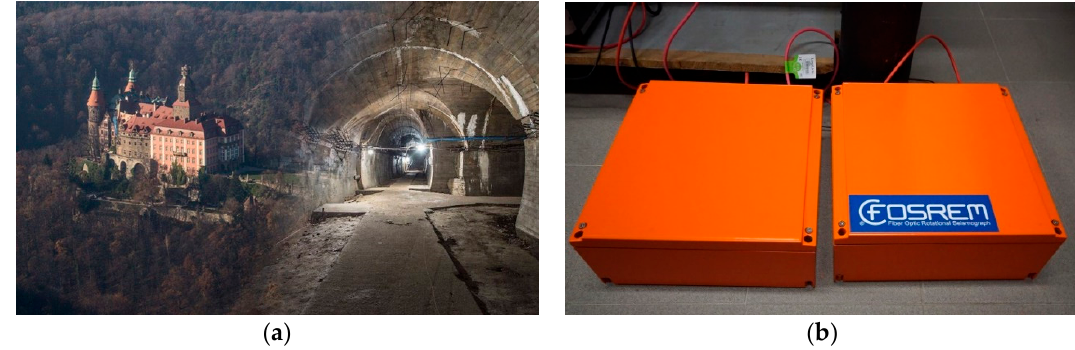
Figure 7. FOSREMs’ field application: ( a ) Ksi ąż castle with view of the underground tunnel located below the surface of the castle, ( b ) mounted devices in the geophysical observatory.